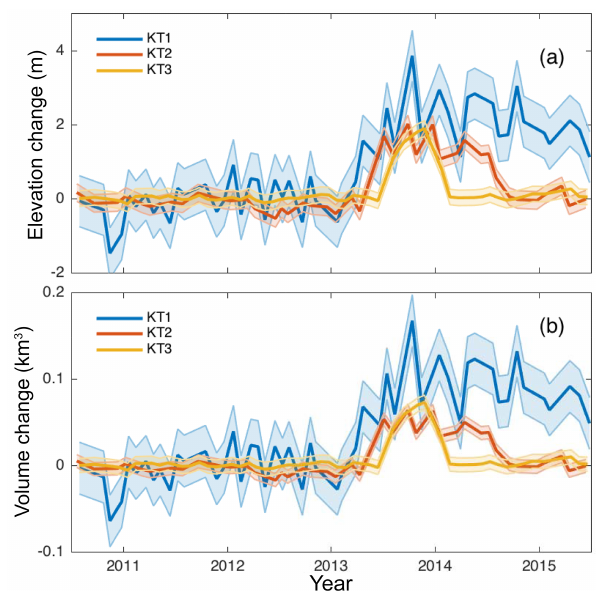
Figure 4. Temporal (a) elevation and (b) volume changes of sub- glacial lakes in the trunk of the KIS. The error ranges are displayed by colored